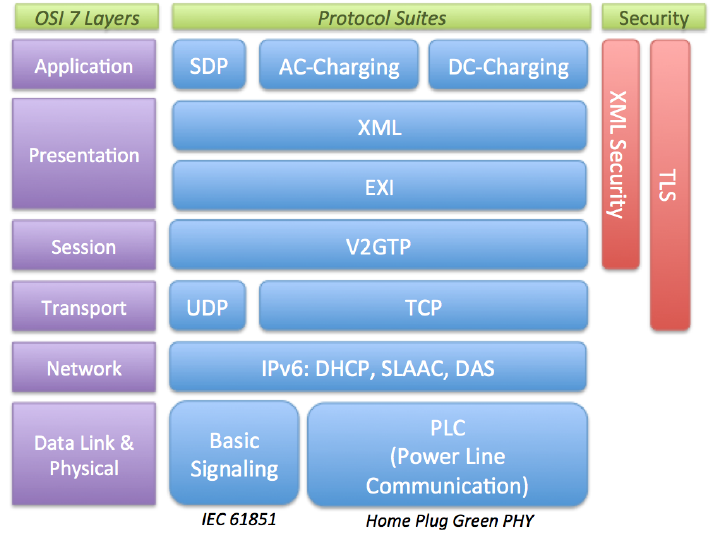
Figure 2. The protocol stack of ISO/IEC